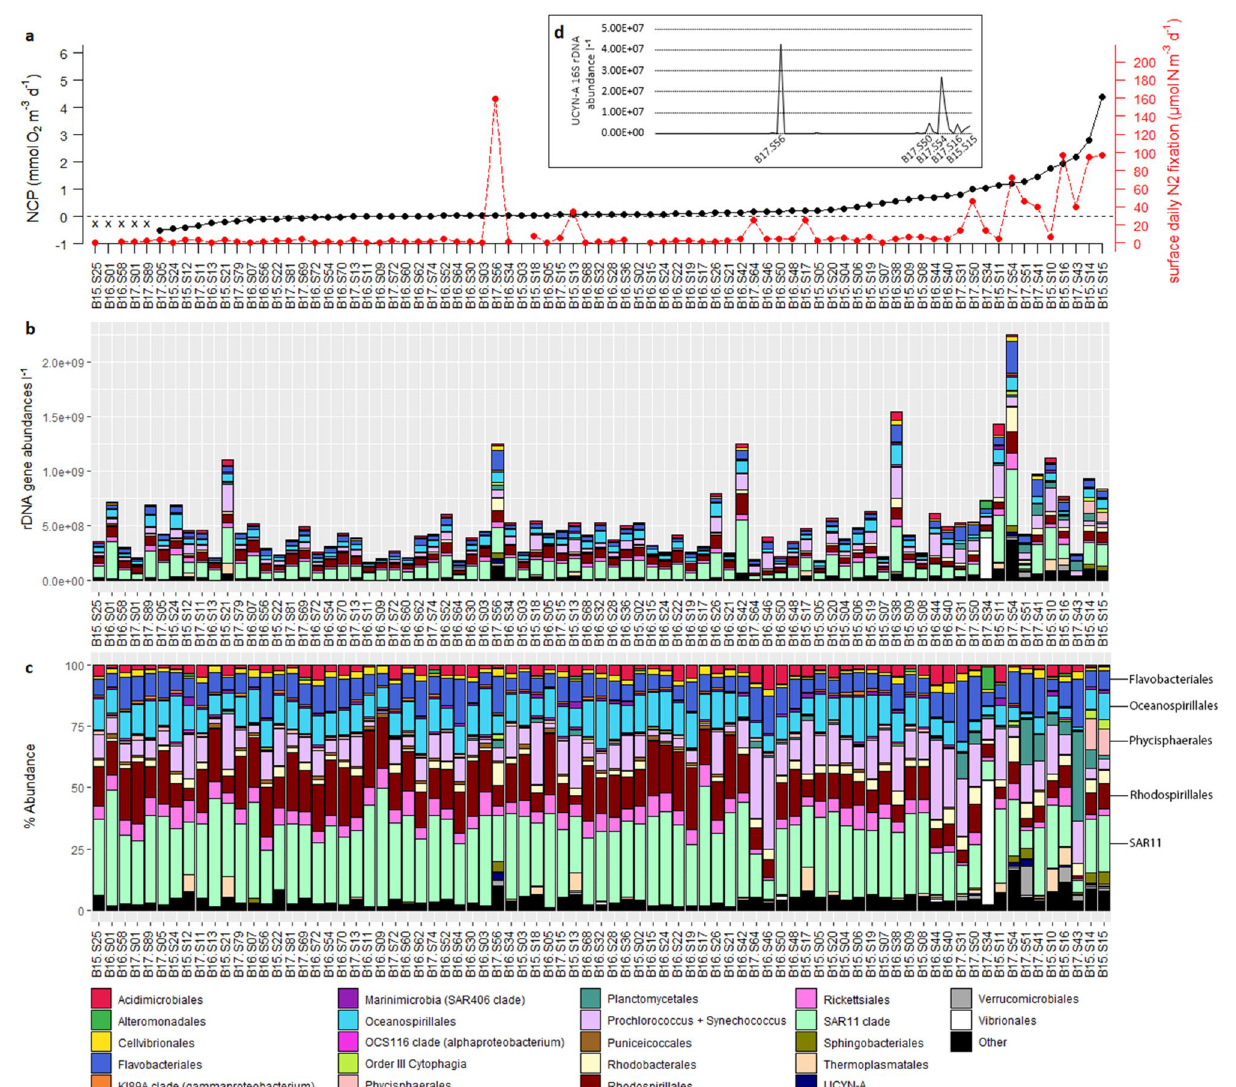
Figure 2. Prokaryotic community structure. ( a) N 2 fixation rates (red) and NCP rates (black) measured at each sampling site 22,36,37 , with sites ranked from left-to-right in order of increasing NCP. Sites at which NCP measurements were not collected are grouped on the far left and denoted with x-marks. Taxa are organized in alphabetical order from top to bottom, following the order outlined in the legend. ( b) Bar plot of 16S prokaryotic taxonomy represented at the order level using quantitative rDNA gene abundances l -1 . ( c) Bar plot of 16S prokaryotic taxonomy at the order level using relative abundances. ( d) UCYN-A1 16S rDNA abundance across sampling sites, with sites ranked from left-to-right in order of increasing NCP and selected sites labeled. Figure created in R 3.5.2 (https ://www.r-proje